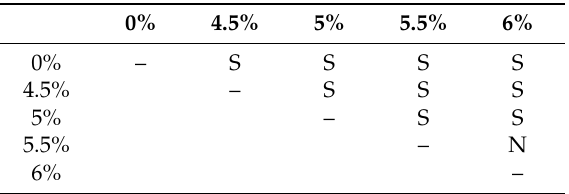
Table 6. Difference analysis of G*/sin δ at different SBS modifier dosages.